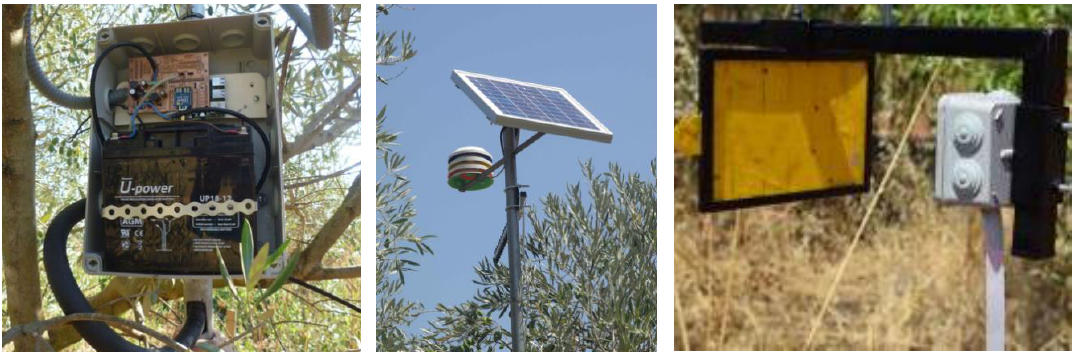
Figure 4. Electronic components of the e-trap. Left: Battery and electronics. Center: Upper part of the e-trap showing solar panel and Stevenson screens that protected temperature and relative humidity (HR) sensors. Right: Camera placed in front of a Rimi ® trap.